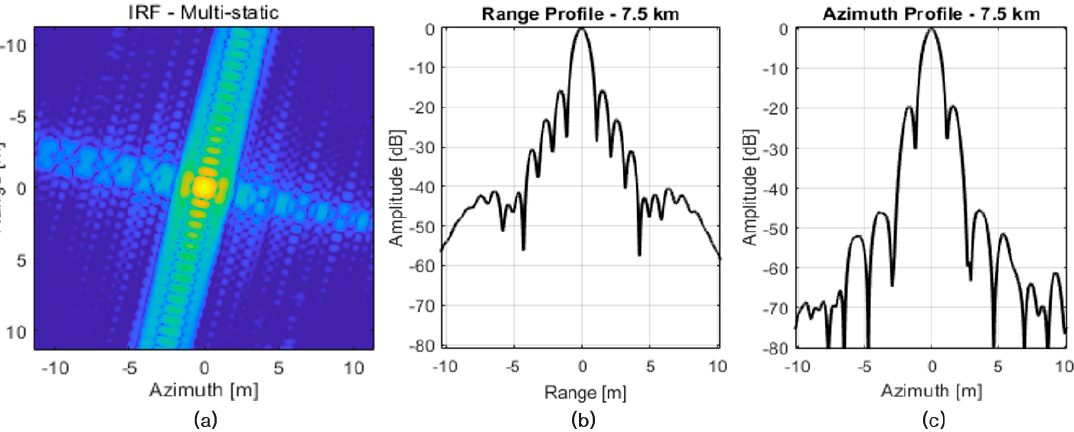
Figure 23. Imaging simulation results of the final designed multistatic SAR system, IRF ( a ), range profile ( b ), and azimuth profile ( c ).